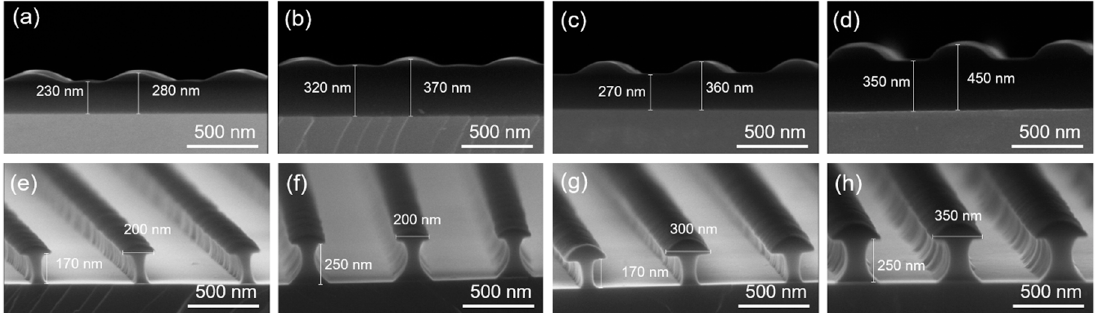
Figure 6. The width of the top photoresist and the thickness of the lift-off layer (LOL) can be adjusted by changing the spin speed of AR-N 4340 and the LOL, respectively. ( a ) The SEM image before developing with both the AR-N 4340 and LOL spin speeds at 6000 rpm. ( e ) The SEM image for ( a ) after developing with 1.2% TMAH for 85 s with a top photoresist width of 200 nm and LOL thickness of 170 nm. ( b ) The SEM image before developing with an AR-N 4340 spin speed of 6000 rpm and LOL spin speed of 2000 rpm. ( f ) The SEM image for ( b ) after developing with 1.2% TMAH for 85 s with a top photoresist width of 200 nm and LOL thickness of 250 nm. ( c ) The SEM image before developing with an AR-N 4340 spin speed of 3000 rpm and LOL spin speed of 6000 rpm. ( g ) The SEM image for ( c ) after developing with 1.6% TMAH for 40 s with a top photoresist width of 300 nm and LOL thickness of 170 nm. ( d ) The SEM image before developing with an AR-N 4340 spin speed of 2000 rpm and LOL spin speed of 2000 rpm. ( h ) The SEM image for ( d ) after developing with 1.6% TMAH for 40 s with a top photoresist width of 350 nm and LOL thickness of 250 nm.